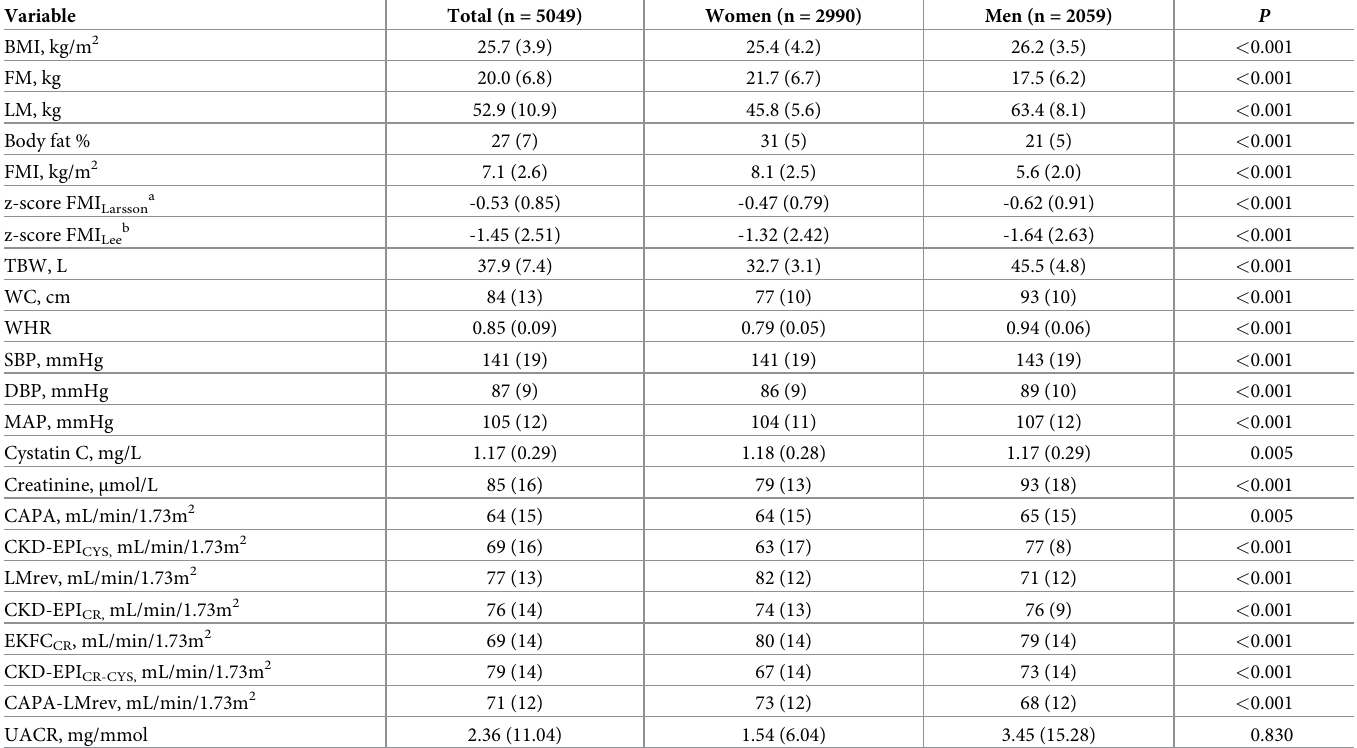
Table 2. Clinical characteristics and comparisons between men and women at